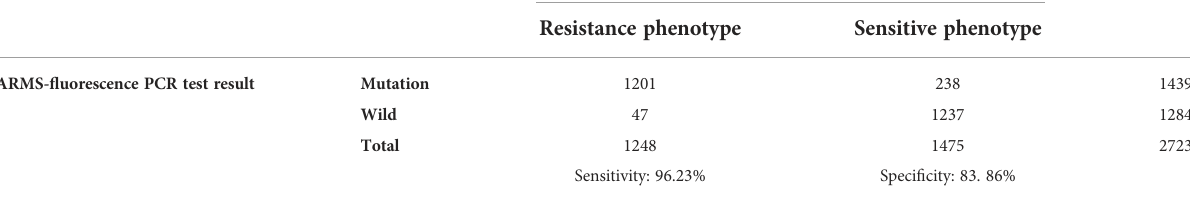
TABLE 3 Comparison of the antibiotic susceptibility test and ARMS- fl uorescence PCR detection of H. pylori clarithromycin resistance gene